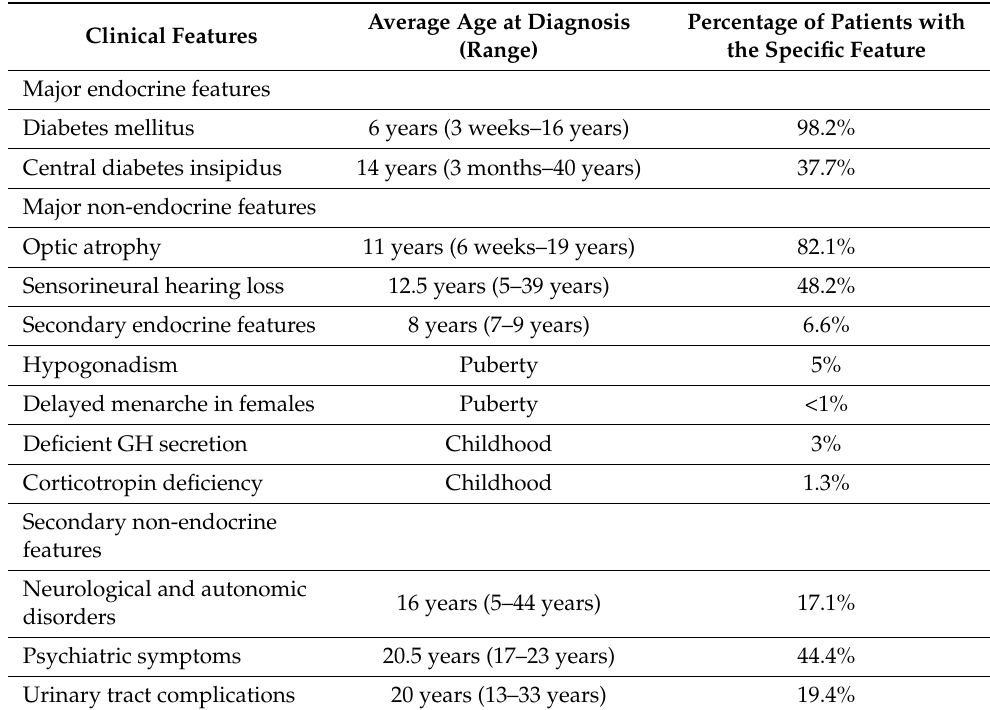
Table 1. Major and secondary features of Wolfram syndrome 1